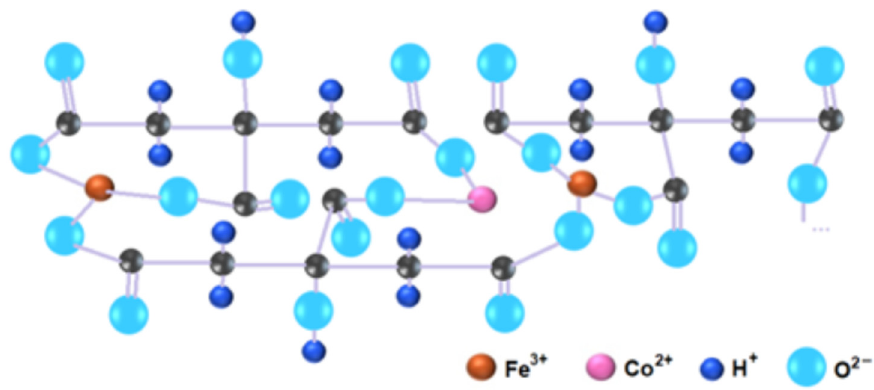
Figure 6. Possible structure of the intermediate citrate complex of transition elements.